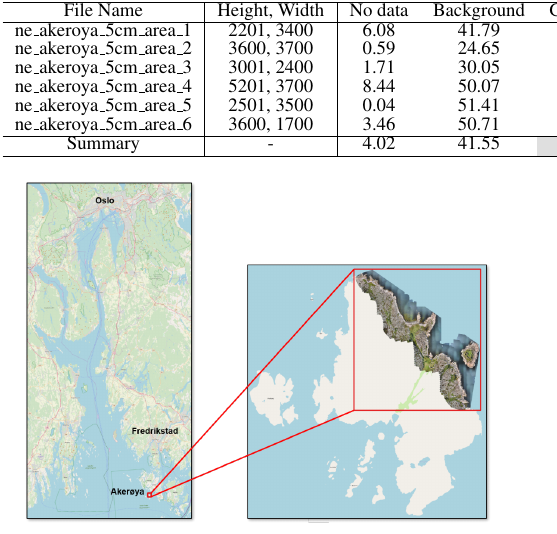
Figure 2. Illustraion of the study